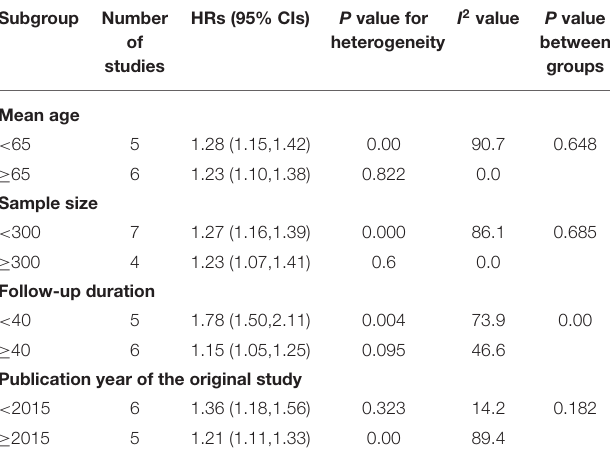
TABLE 2 | Subgroup analyses of the association between galectin-3 and risk of ACD in CHF patients. Subgroup Number